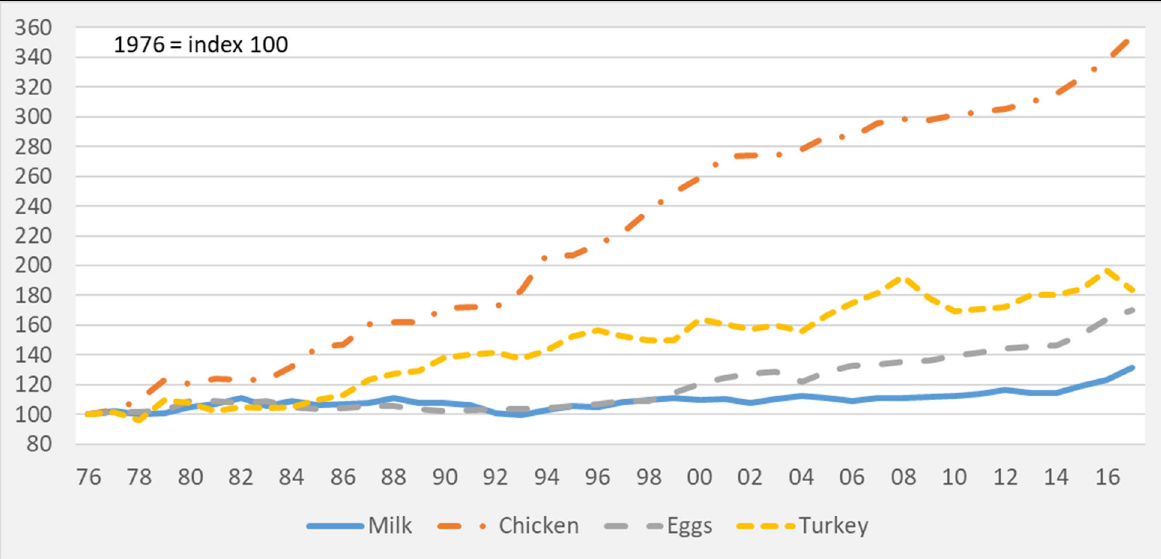
Figure 1. Evolution of Production in Sectors Under Supply Management, Canada, 1976–2017